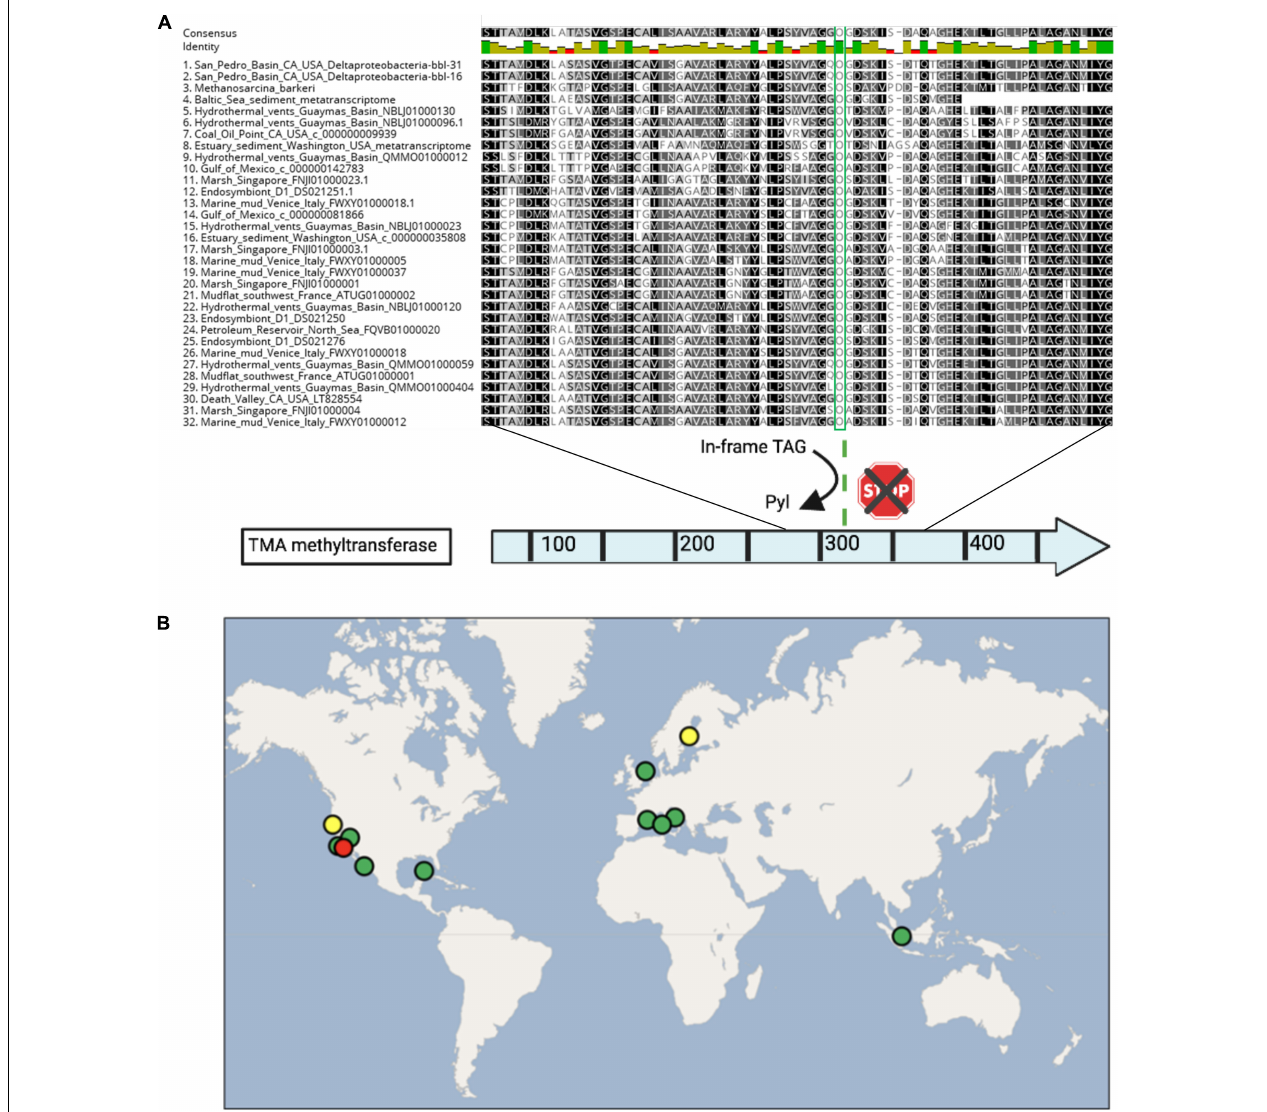
FIGURE 5 | (A) Alignment of select residues of the trimethylamine methyltransferase protein, spanning the pyrrolysine residue (in green), as well as the conserved residues following the UAG codon. Proteins are shown from the Deltaproteobacteria-bbl genomes from this study, Methanosarcina barkeri for comparison, and Deltaproteobacteria from other studies, including two transcriptomics data sets. (B) The global distribution of dual genetic code expansion-enabled Deltaproteobacteria that have the trimethylamine methyltransferase and conserved Pyl residue, as well as Sec and Pyl machinery genes. Circle colors are as follows: red indicates this study, yellow indicates metatranscriptomic data sets, and green includes metagenomic/genomic data sets. The location source and type of each dataset is provided in Supplementary Table 11